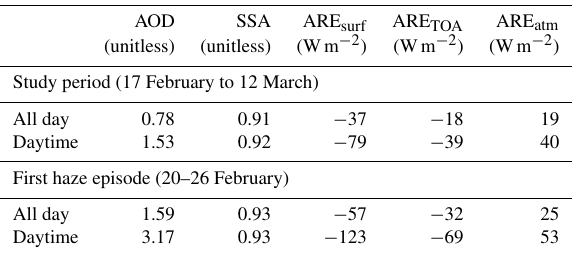
Figure 6. The model-simulated (a) air temperature (T2), (b) relative humidity (RH2), (c) wind speed (WS10), (d) PBL height, (e) PM 2 . 5 concentration, (f) AOD, (g) SSA, (h) all-sky aerosol radiative effect (ARE) at the surface, (i) all-sky ARE at the top of atmosphere and (j) all-sky ARE in the atmosphere from the FULL case. Numbers in the parentheses are averages over the BTH region during the entire study period. Table 4. The model-simulated domain and period averages of AOD, SSA, and AREs from the FULL case over the BTH